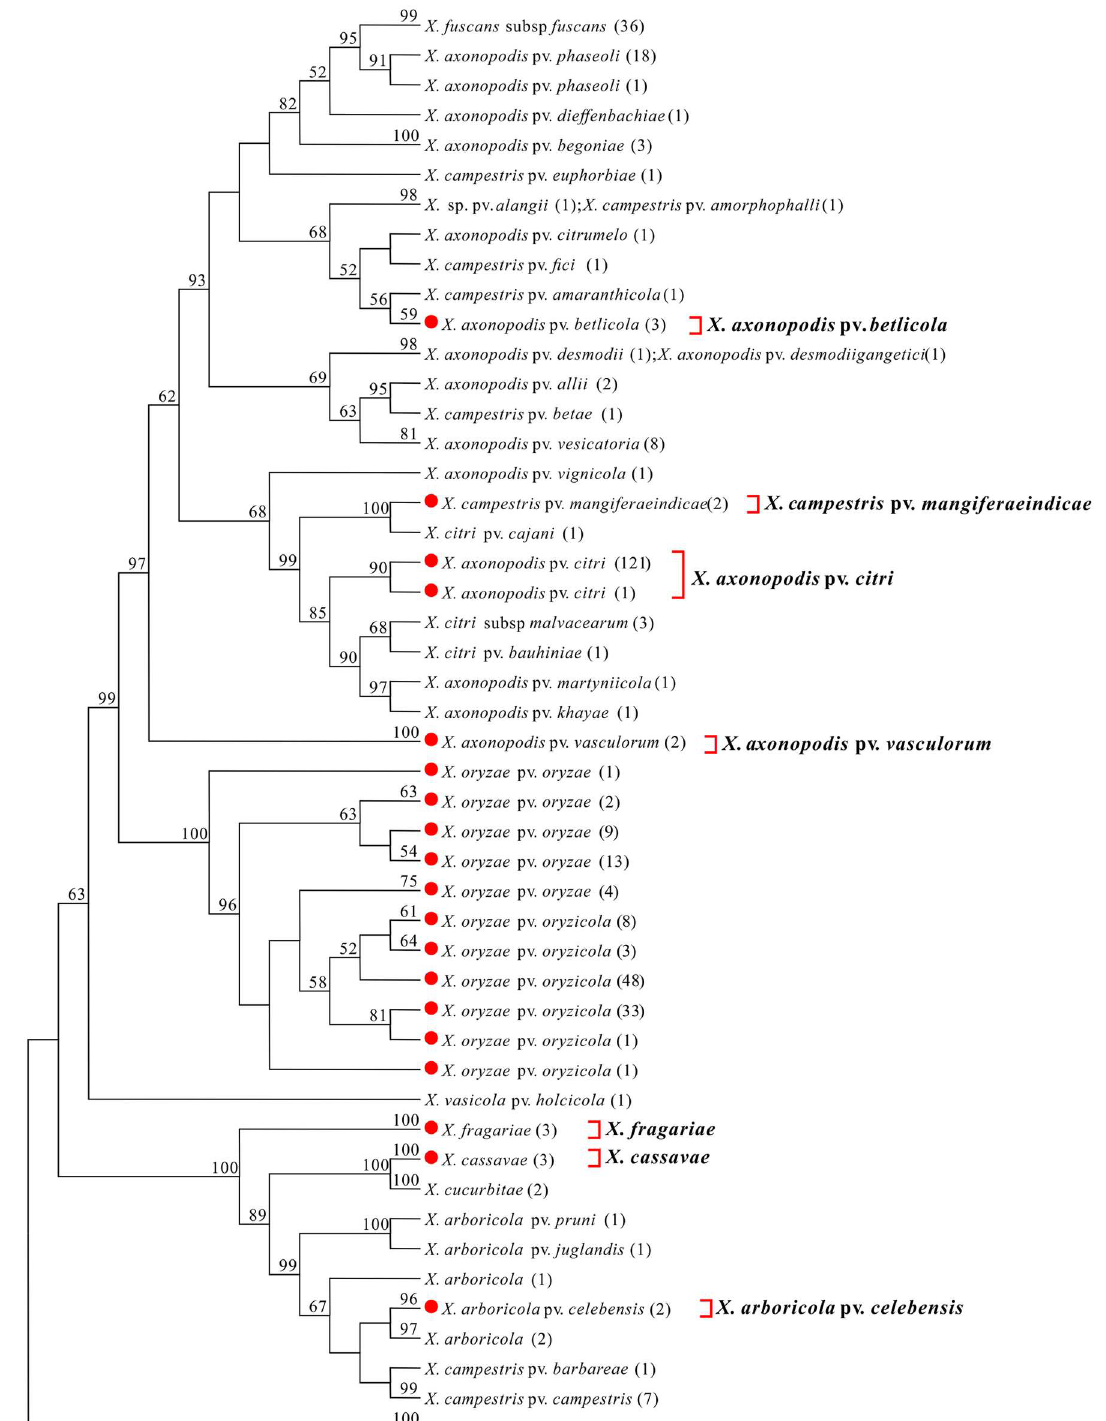
Fig 3. Neighbor-joining tree based on avrBs2 . Bootstrap values ( > 50%)are shown abovethe branches. Identical sequencesare represented only once. Numbers followingtaxon names indicatethe numberof isolates. Red dots indicate quarantine Xanthomonas species/pathovars. Species/pathovars that were successfully identifiedare shown on the right.